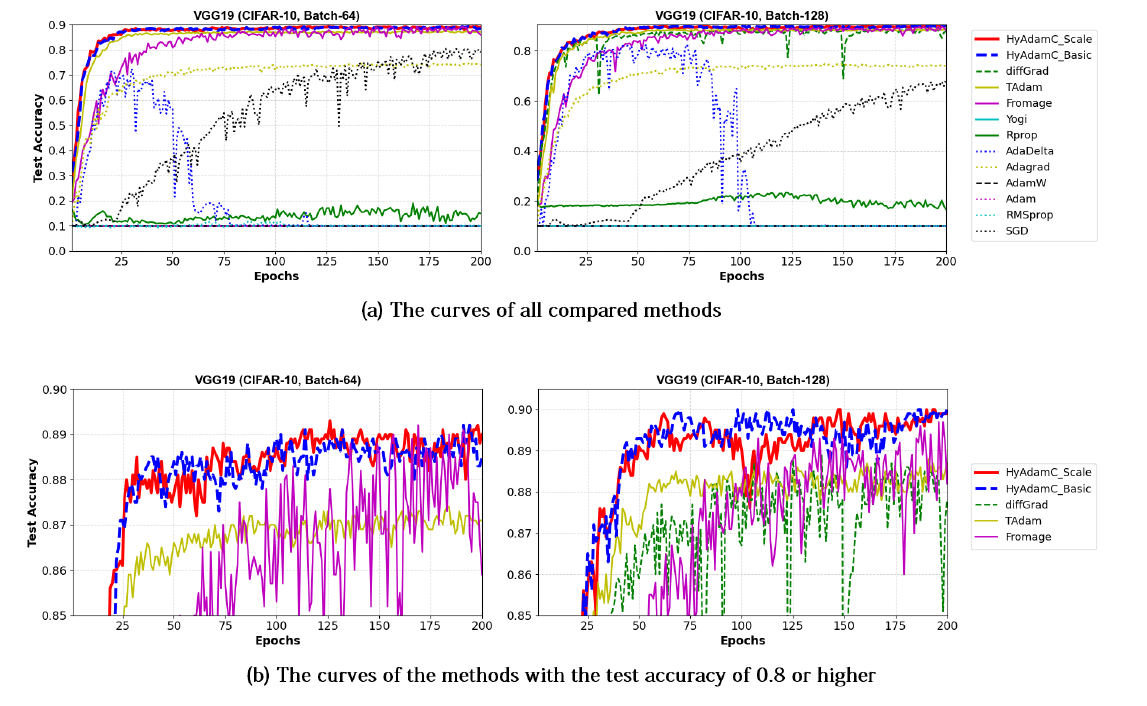
Figure 16. The test accuracy curves of the VGG-19 trained by HyAdamC and other optimization methods in the CIFAR-10 image classification tasks. In this figure, ( a ) shows the test accuracy curves of all compared methods. On the other hand, ( b ) illustrates the plots in which a range of the y-axis of the plots described in ( a ) is zoomed into between 0.85 and